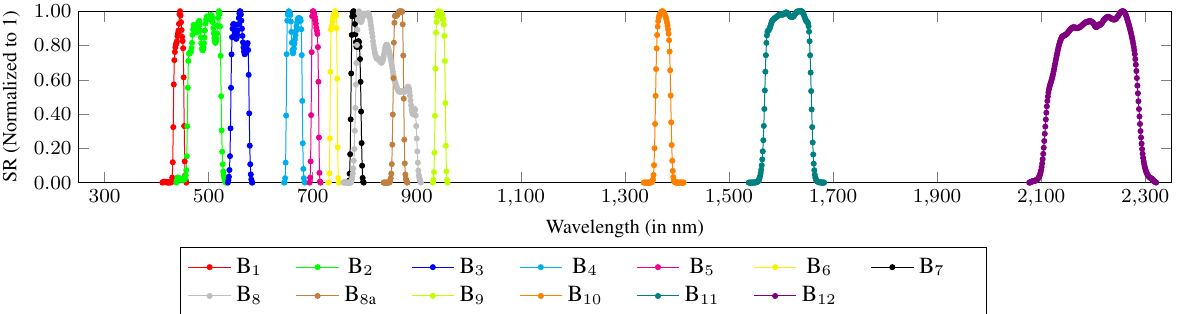
Figure 2. Visualization of the Sentinel-2 Spectral Response Functions (S2-SRFs), i.e. the measured spectral response (SR) for each band of the Sentinel-2 MultiSpectral Instrument